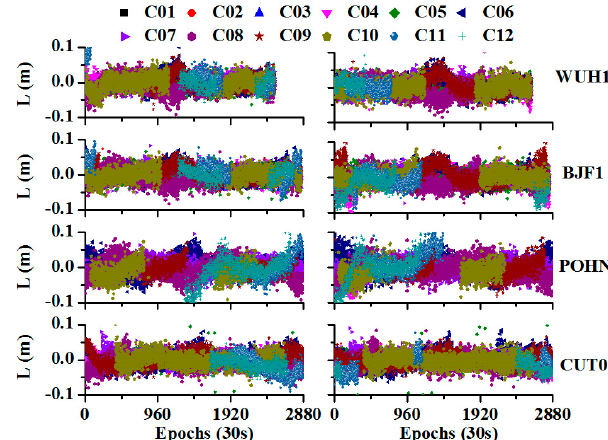
Figure 7. Time series of the array L for different stations and different days (the left side represents the day of year (DOY) 199, and the right side represents the DOY 202).